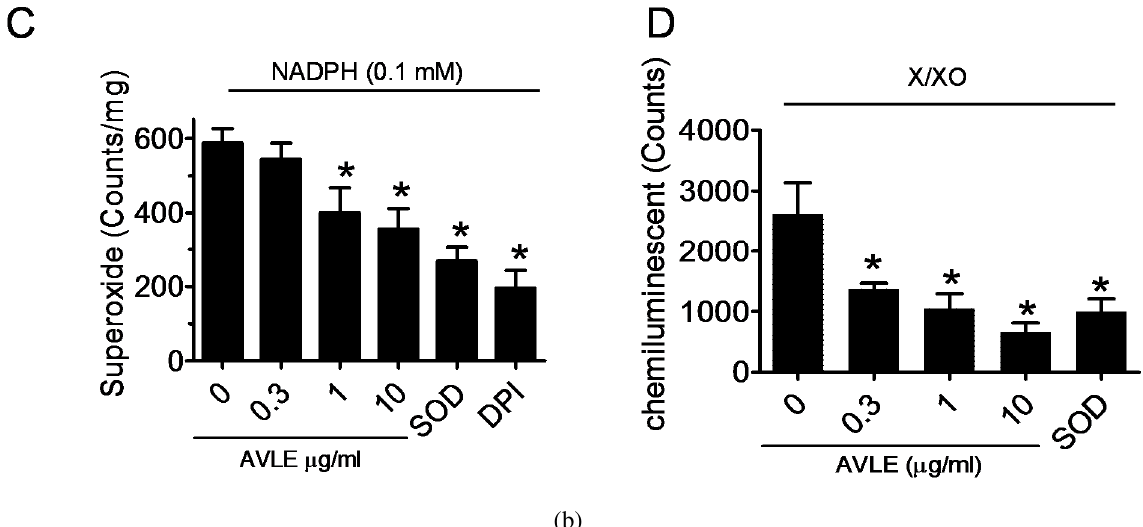
Figure 5. AVLE reduced superoxide generation in both cell and cell-free-mediated superoxide generation systems. The effect of AVLE (0.3, 1 and 10 µg/mL) on ( A , B ) superoxide generation from aortic rings using DHE and ( C ) lucigenin-enhanced chemiluminescence in the presence of 0.1 mM NADPH. Diphenyleneiodonium (DPI, 5 µM) was used as NADPH oxidase inhibitor. ( D ) Effect of AVLE and superoxide scavenger, SOD on the superoxide production by X/XO generating system determined by lucigenin-enhanced chemiluminescence. Results are means ± SEM ( n = 3–5). # p < 0.05 compared to control, * p < 0.05 compared to zero concentration of AVLE.